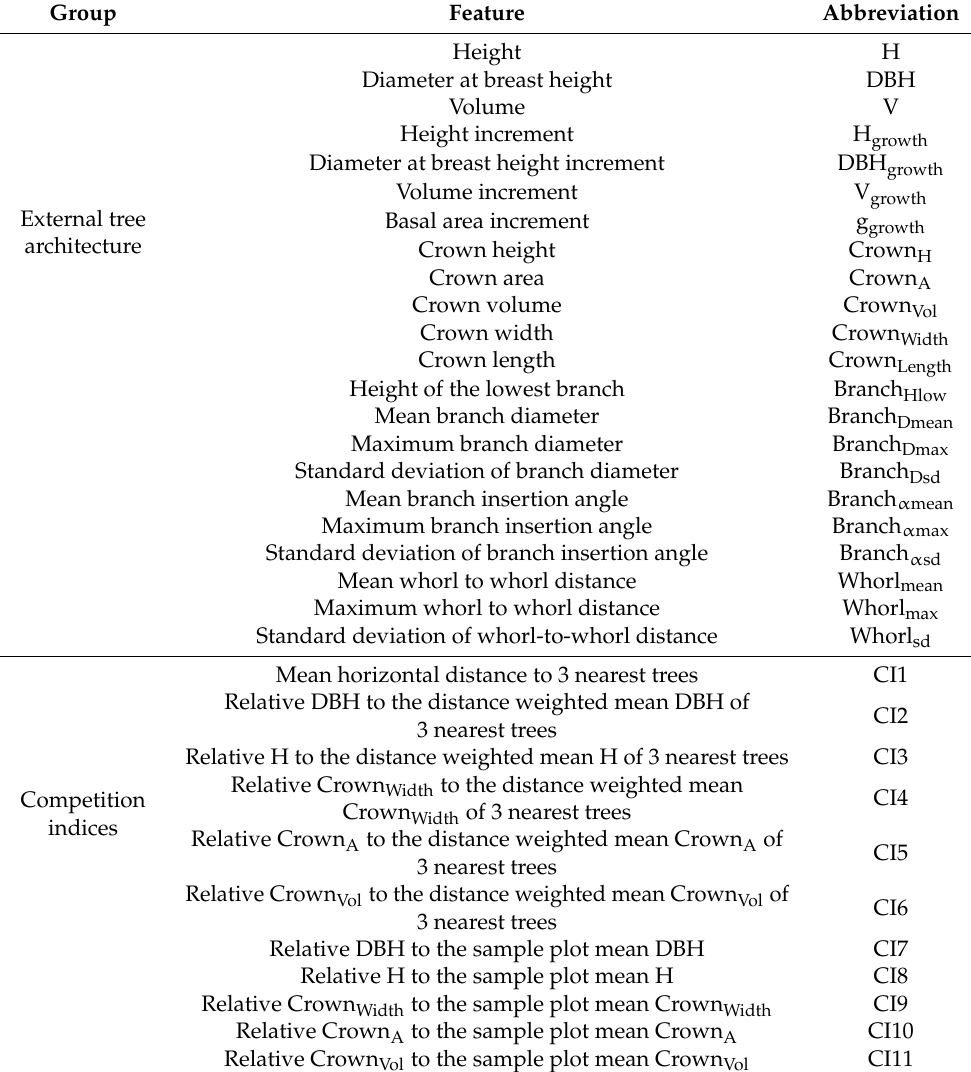
Table 2. The final set of derived structural characteristics describing the external tree architecture and competition